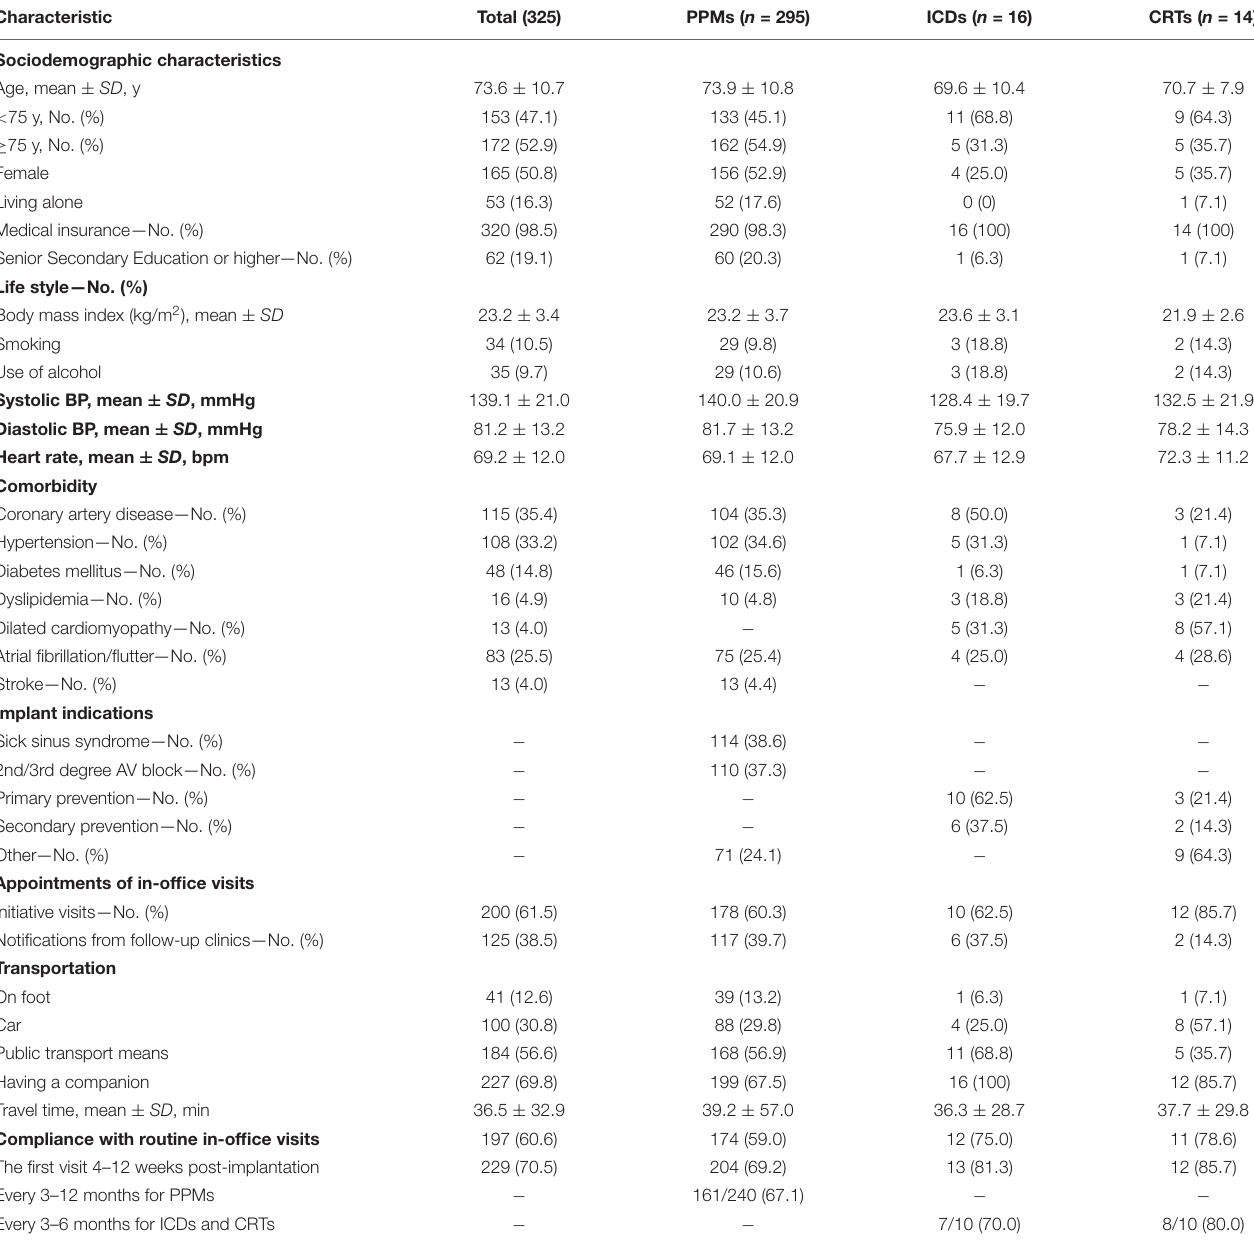
TABLE 1 | Baseline characteristics of patients from each cardiac implantable electronic device groups. Characteristic Total